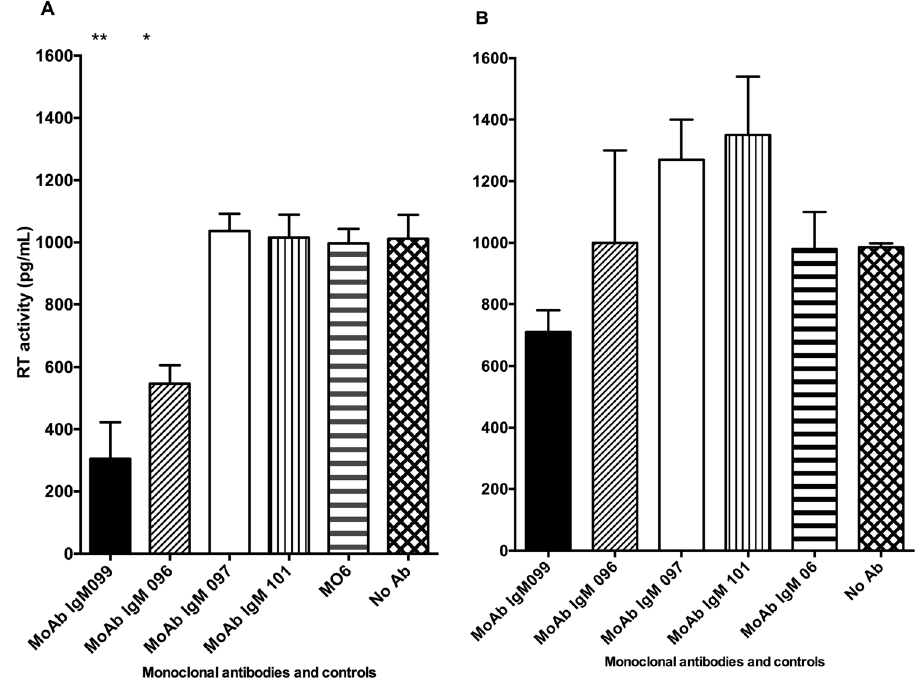
Figure 5. Inhibition of HIV-1 by human IgM monoclonal antibodies against HIV-1 envelope in human cervical mucosa biopsies and transfer and infection of dendritic cells. Inhibition of HIV-1 actively replicating (RT enzyme activity) from anti-HIV IgM-treated ectocervical biopsy tissue. ( A ) The quantitative RT activity (pg/ml) in the supernatant at the end of the study period. The bars illustrate the median and range from representative duplicate well inhibition assays. Mann Whitney U test was used to determine if the samples were significantly different than the negative control ( ** p < 0.01, * p < 0.05). ( B ). Figure 5B ( C ) The quantitative RT activity (pg/ml) in the supernatant at the end of the study period. The bars illustrate the median and range from representative duplicate well inhibition assays ( ** p < 0.01, * p <